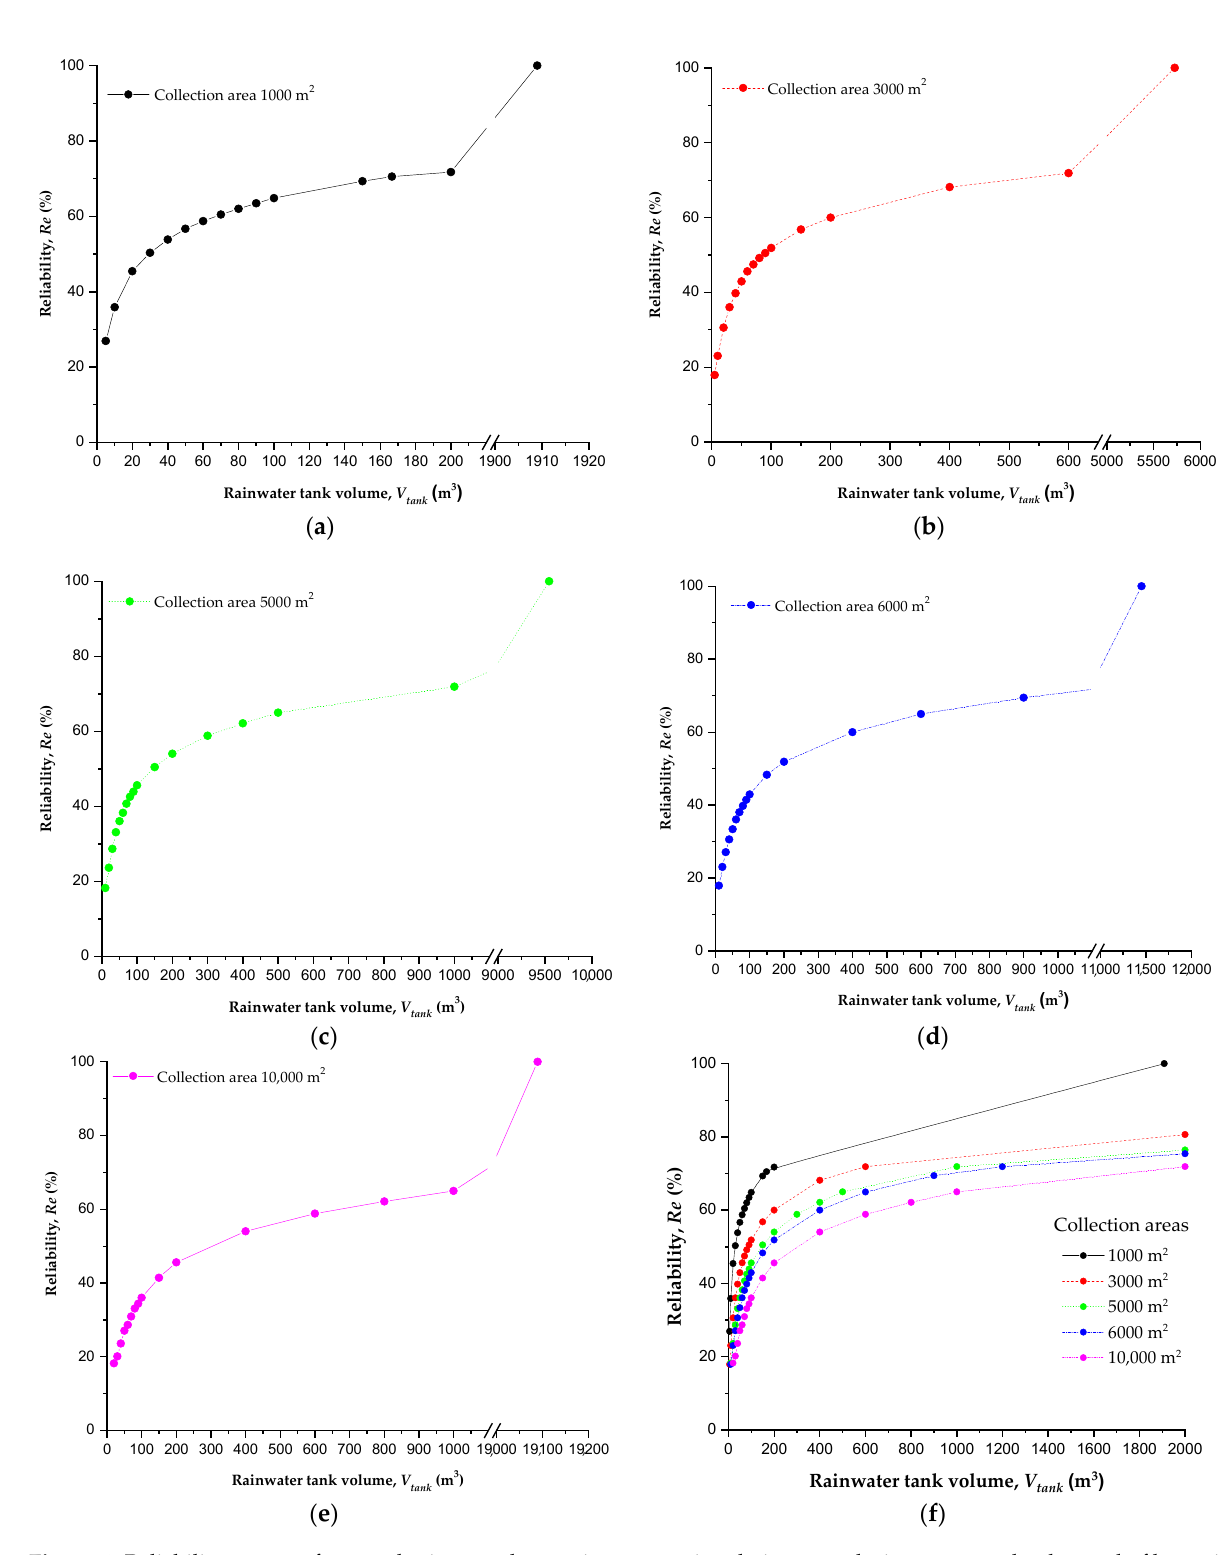
Figure 4. Reliability curves of covered rainwater harvesting system in relation to tank sizes to meet the demand of begonia